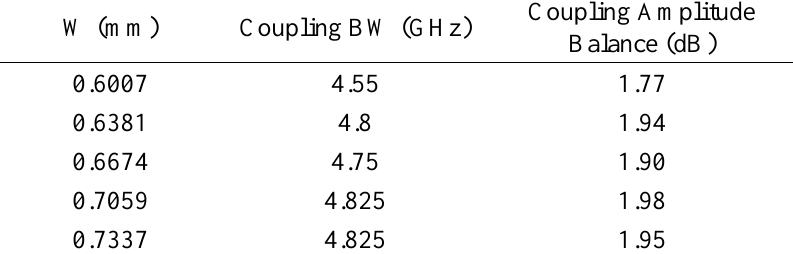
Table 3. Coupler performance vs. an oblique stub